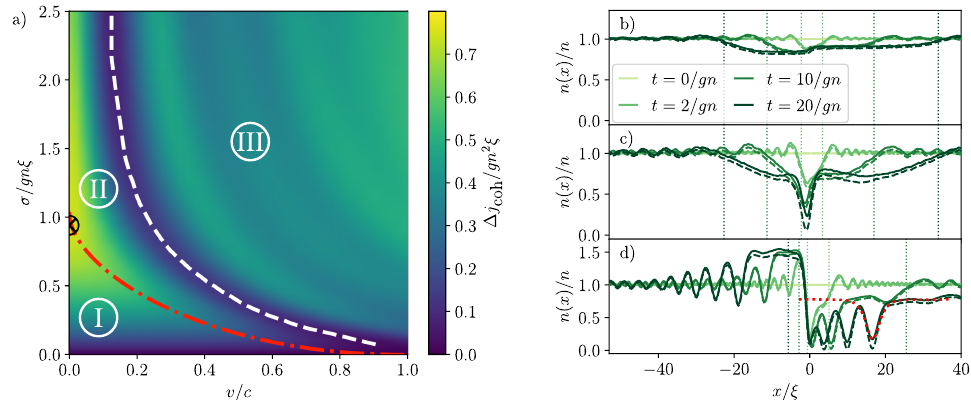
Figure 3: a) Phase diagram of a noisy point contact of strength σ in a BEC moving with velocity v . We plot the total coherent current flowing towards the impurity on the left and on the right of the point contact, which equals the scattering rate of the dissipative impurity. We average in space over the interval x ∈ ± [ 2,5 ] ξ and in time over t ∈ [ 10,20 ] / gn , where the intervals are chosen to be within the ‘sound’ cone, but large enough to average over multiple oscillations in the dynamically unstable phase III. The red line marks the estimated transition between linear response and Zeno regime which agrees well with the local maximum for fixed v , see Appendix C for details. The white dashed line marks the transition form the Zeno to the soliton = 2 c / 3 of the transition form normal to Zeno phase regime. The analytical result σ c at v = 0 [ 64 ] is shown by the black circle. b)-d) Density close to the noisy point contact at different times. Shown are in b) the normal phase I for σ = 0.2 gn ξ and v = 0.2 c , in c) the Zeno phase II for σ = 0.7 gn ξ and v = 0.2 c ; and in d) the soliton phase III for σ = 2 gn ξ and v = 0.8 c . The times marked in color are the same in all three plots. Solid, dashed and dotted lines are chosen as in Fig. 3. The red dotted line in d) is the profile of a grey soliton fitted to the simulated